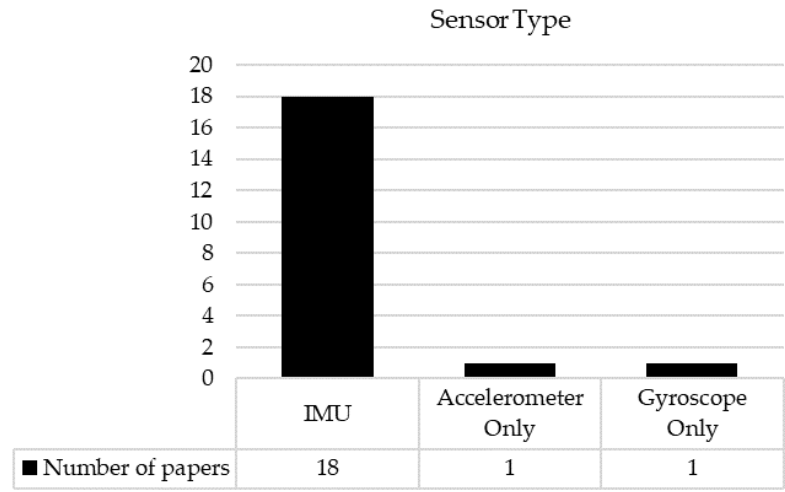
Figure 3. The number of papers for each sensor type.